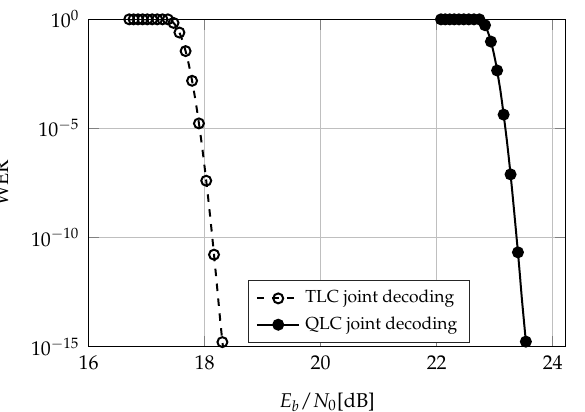
Figure 10. Comparison of TLC and QLC with respect to the signal-to-noise ratio; GC codes with joint coding, rate R = 0.9, and 4 kB of payload